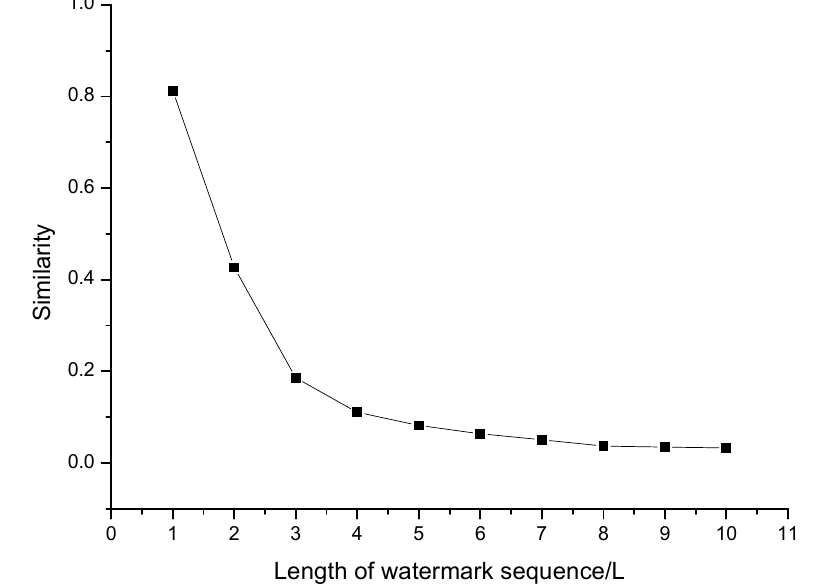
Figure 11. Effect of watermarking redundancy